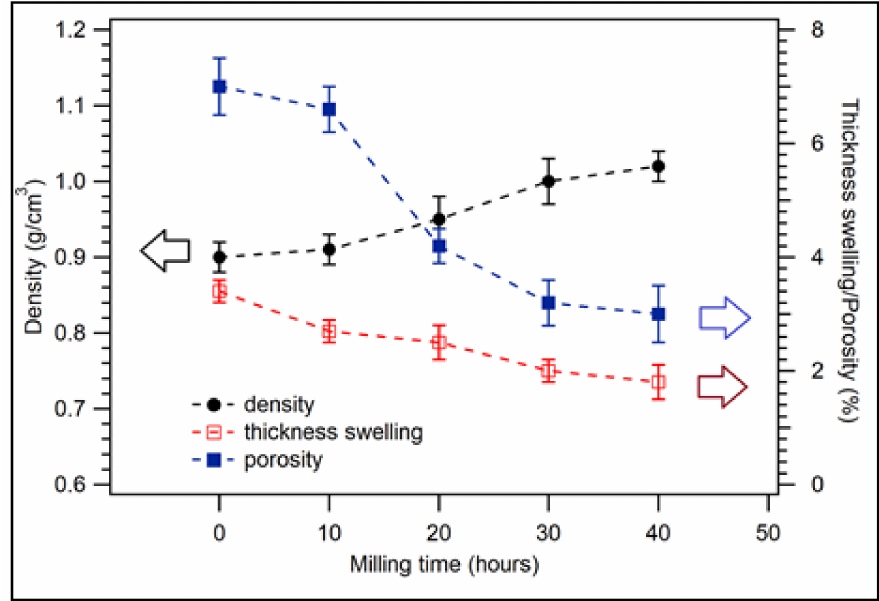
Figure 6. Physical properties of coconut shell nano-biocomposite for various milling times with 30 wt.% of PP